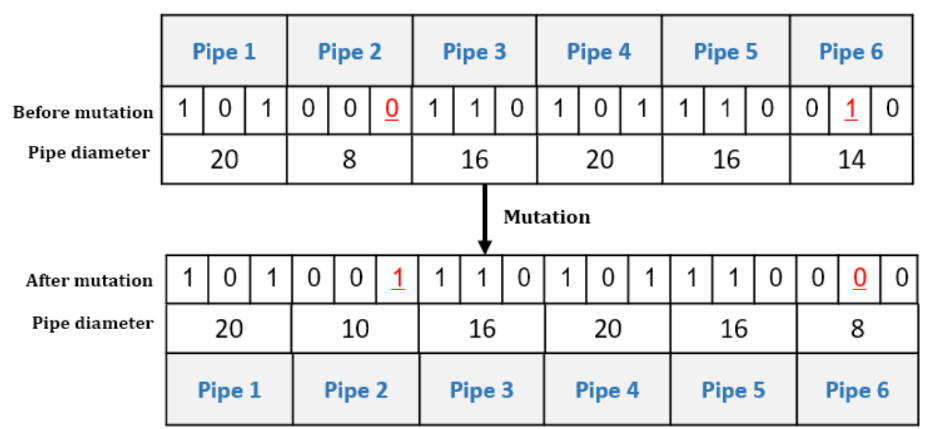
Figure 4. Bit flip